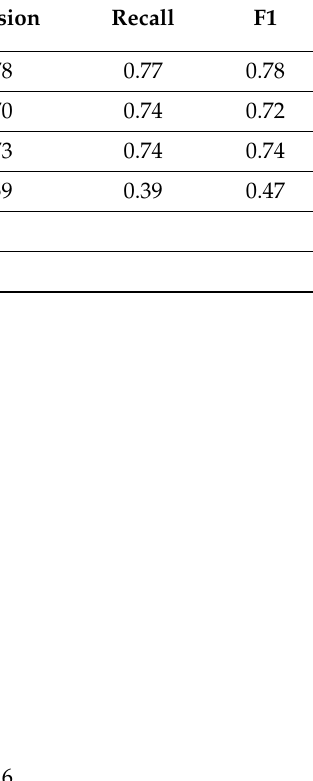
Figure 15. The training behavior of the model based on VGG16.